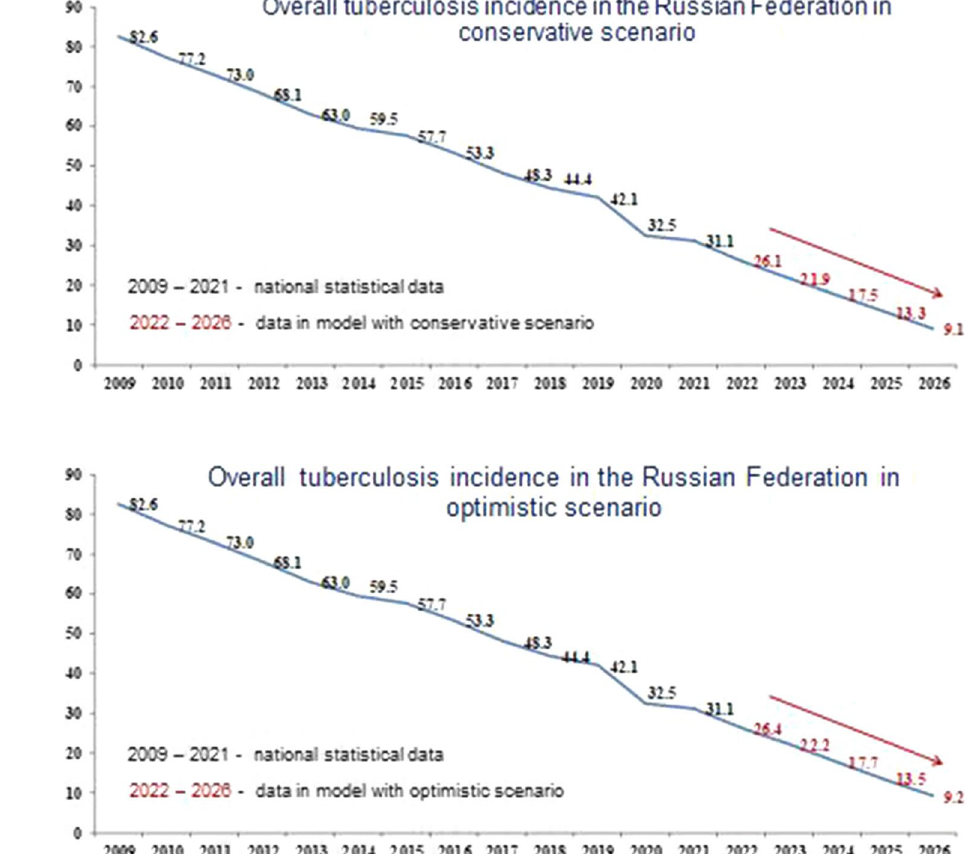
Fig. 2 Forecast of the overall tuberculosis incidence in the Russian Federation with the conservative scenario